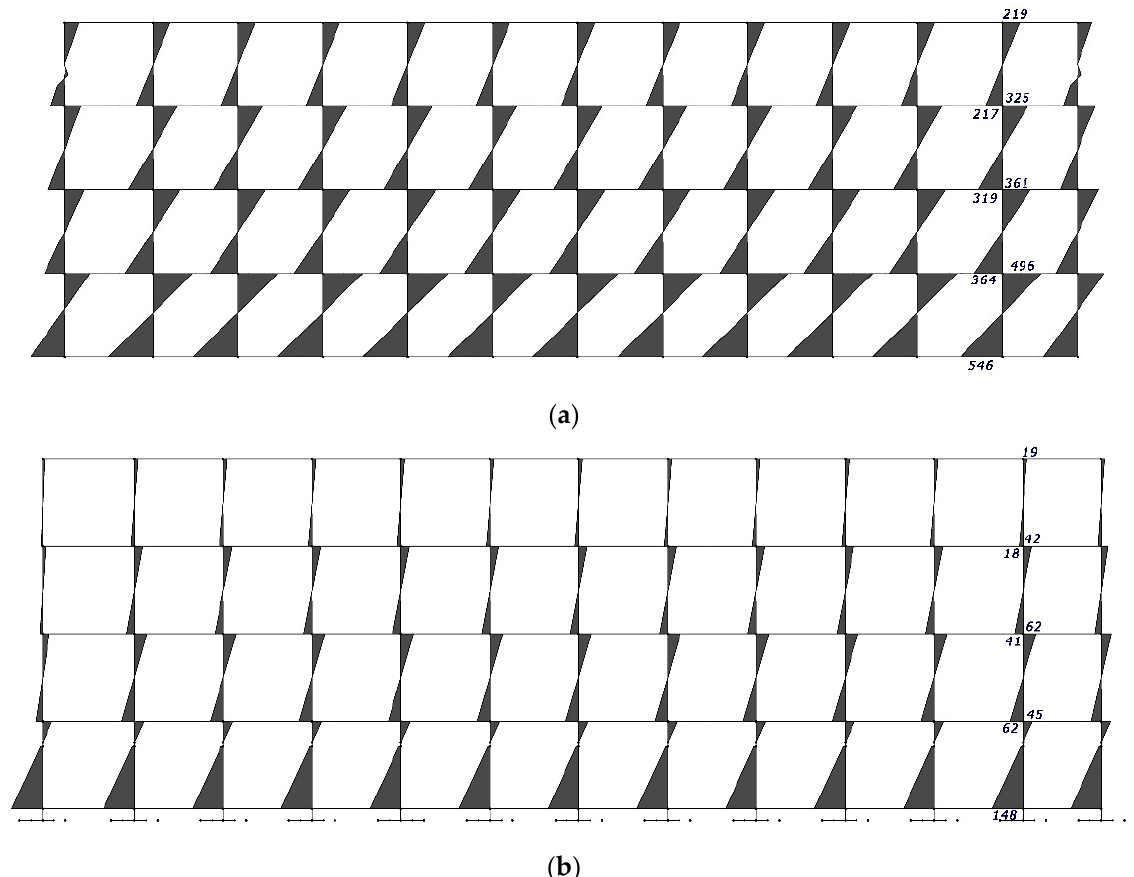
Figure 17. Example of numerically calculated bending moment in RC columns for longitudinal frames in the x -direction (Midas): ( a ) non-isolated (NB) or ( b ) isolated (IB) building system (values in kNm).